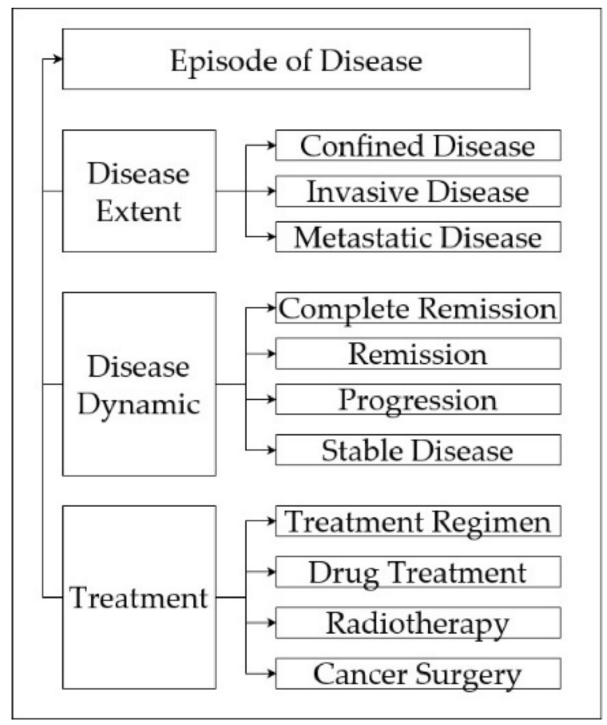
Figure 1. Imputed concepts involved for the episodic